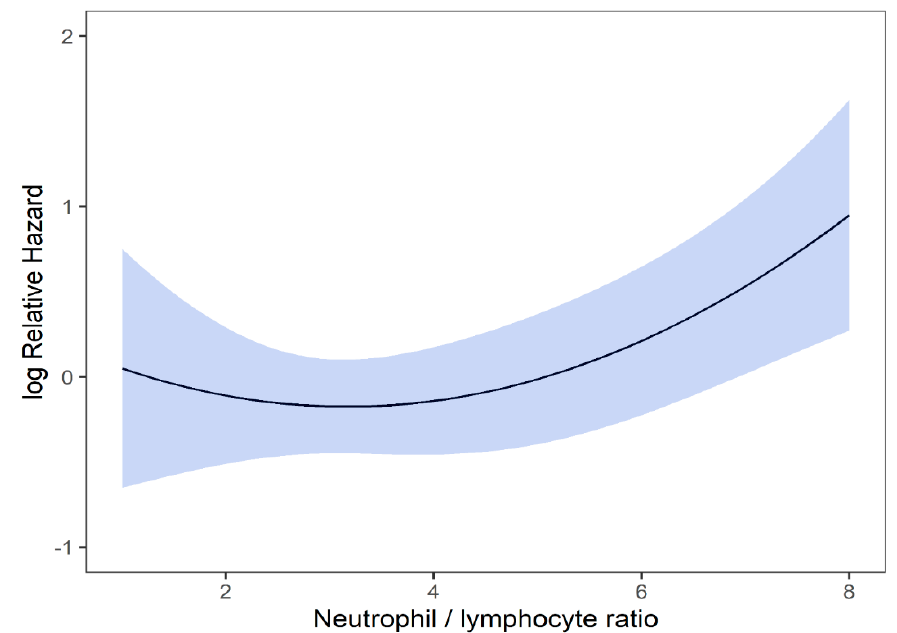
Figure 6. Risk of LRFS by NLR.